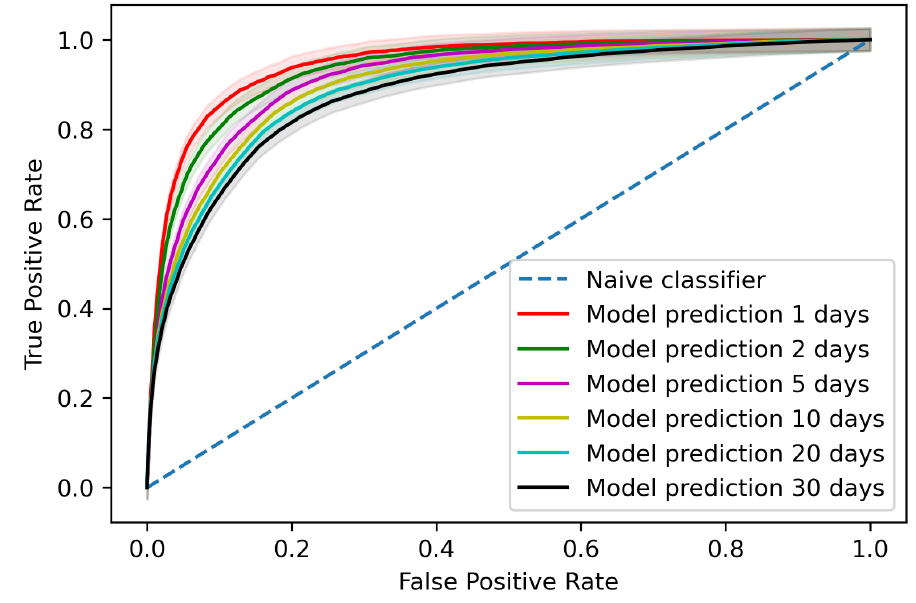
Figure 2. Area under the receiver operating characteristic curve (AUROC) when assessing predictions per blood test. The various lines show the AUROC of 0.881 (95% CI 0.878–0.883) for AKI predictions within 30 days, 0.893 (95% CI 0.891–0.895) within 20 days, 0.903 (95% CI 0.901–0.906) within 10 days, 0.917 (95% CI 0.914–0.920) within 5 days, 0.934 (95% CI 0.930–0.937) within 2 days and 0.947 (95% CI 0.944–0.950) within 1 day, whilst the dashed line shows the comparison to a naive classifier.